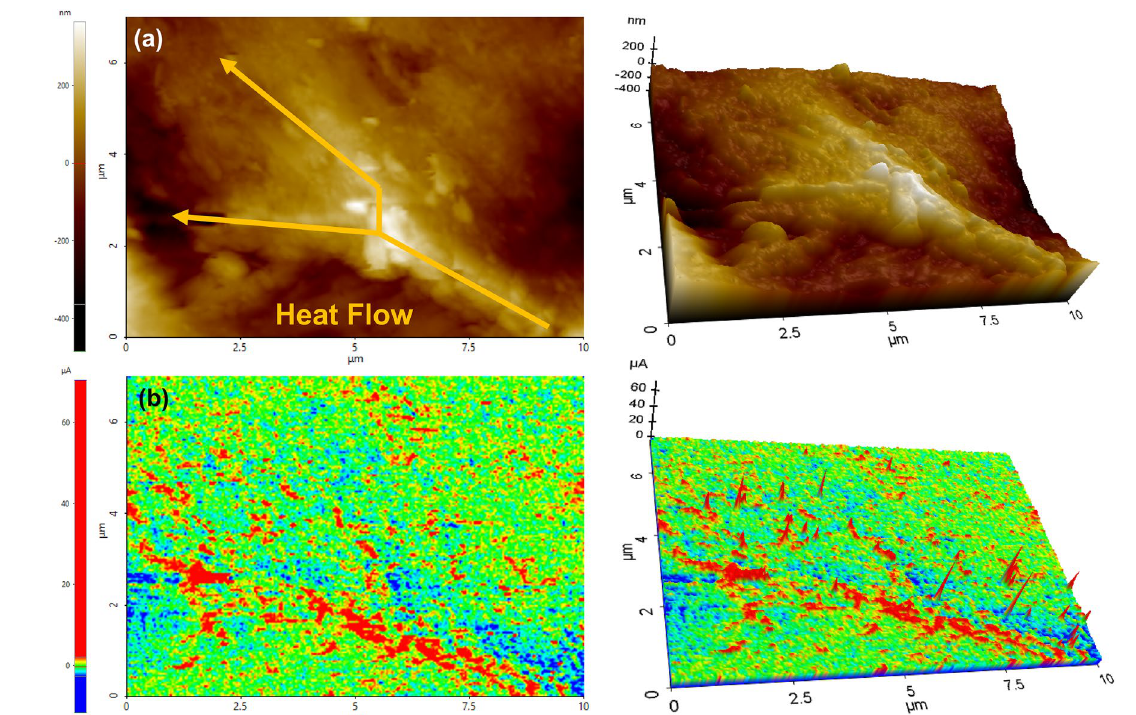
Fig. 4 a Topography and b SThM and their relevant 3D graphics of MGPP100-3 composite. The scanning area is 10×7 μm